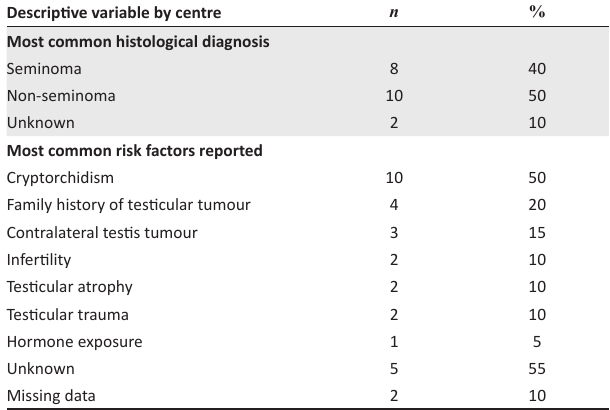
FIGURE 1: Respondent countries and new case TABLE 2: Demographic characteristics of respondents ( n = 20). TABLE 3: Epidemiological data ( n = 20).